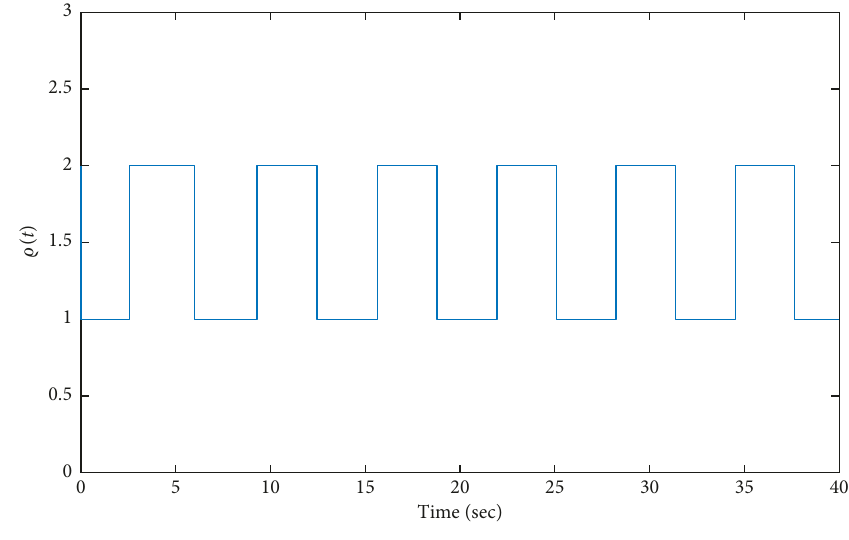
Figure 6: Switching signal 9 ( t )